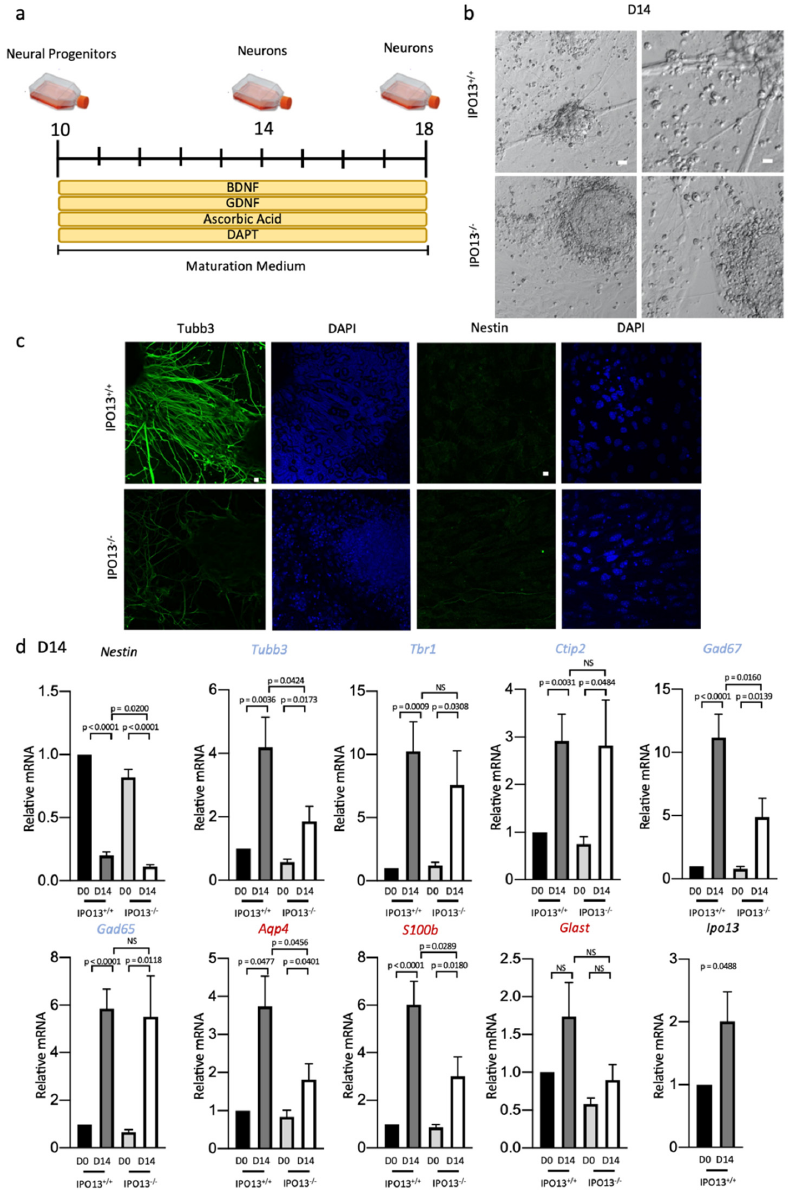
Figure 4. Absence of IPO13 impairs differentiation of progenitor cells to neurons at D14. IPO13 +/+ and IPO13 − / − D10 cells were induced to differentiate toward the dorsal forebrain neuron fate ( a ). ( b ). Representative images of IPO13 +/+ and IPO13 − / − cells imaged at differentiation D14 using phase contrast. Scale bar = 50 µ m. ( c ). Representative images of Nestin and Tubb3 immunostaining from D14 in IPO13 +/+ and IPO13 − / − cells. Scale bar = 10 µ m. ( d ). RNA was extracted from IPO13 +/+ and IPO13 − / − cells at differentiation D10 and D14. Transcript levels were assessed using SensiMix SYBR Green. Gene names in blue and red denote neuronal and astrocyte markers, respectively. Results for gene expression were normalised to the expression of housekeeping genes Sdha , Tbp , and 18s . Data were relativised to IPO13 +/+ D10 expression values. Results represent the mean ± SEM ( n = 5, where cDNA samples were measured in duplicate). p values as per Figure